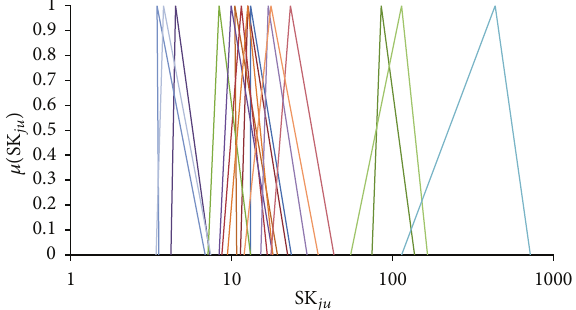
Figure 5: The fuzzy slacks obtained by using Wang et al.’s